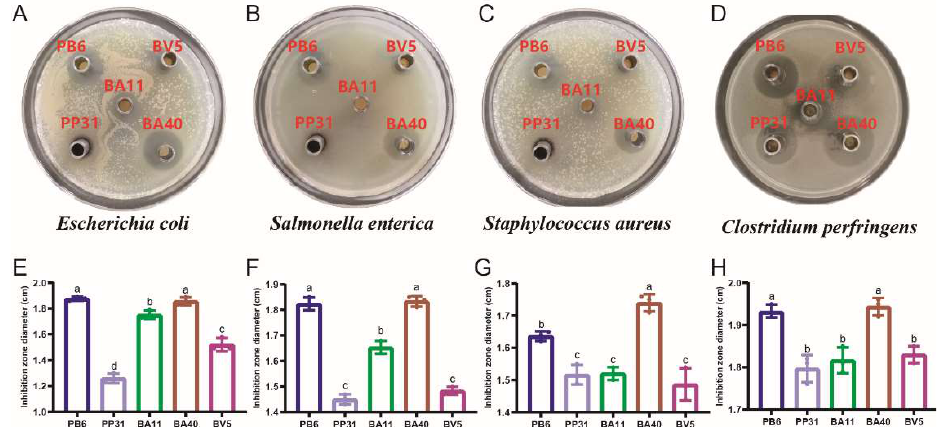
Figure 2. Agar well diffusion assay illustrating the growth inhibition of pathogenic bacteria by cell- free supernatants extracted from the isolated strains. ( A ) Escherichia coli plate. ( B ) Salmonella enterica plate. ( C ) Staphylococcus aureus plate. ( D ) Clostridium perfringens plate. ( E ) Inhibition zone diameter of Escherichia coli ( F ) Inhibition zone diameter of Salmonella enterica ( G ) Inhibition zone diameter of Staphylococcus aureus ( H ) Inhibition zone diameter of Clostridium perfringens . a, b, c Means values with dissimilar letters were significantly different ( p < 0.05). All values contained three repetitions.